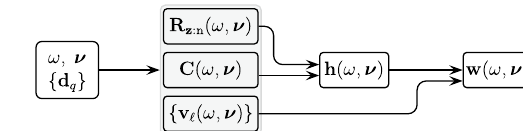
Fig. 5 Workflow for computation of LCMV subband beamforming